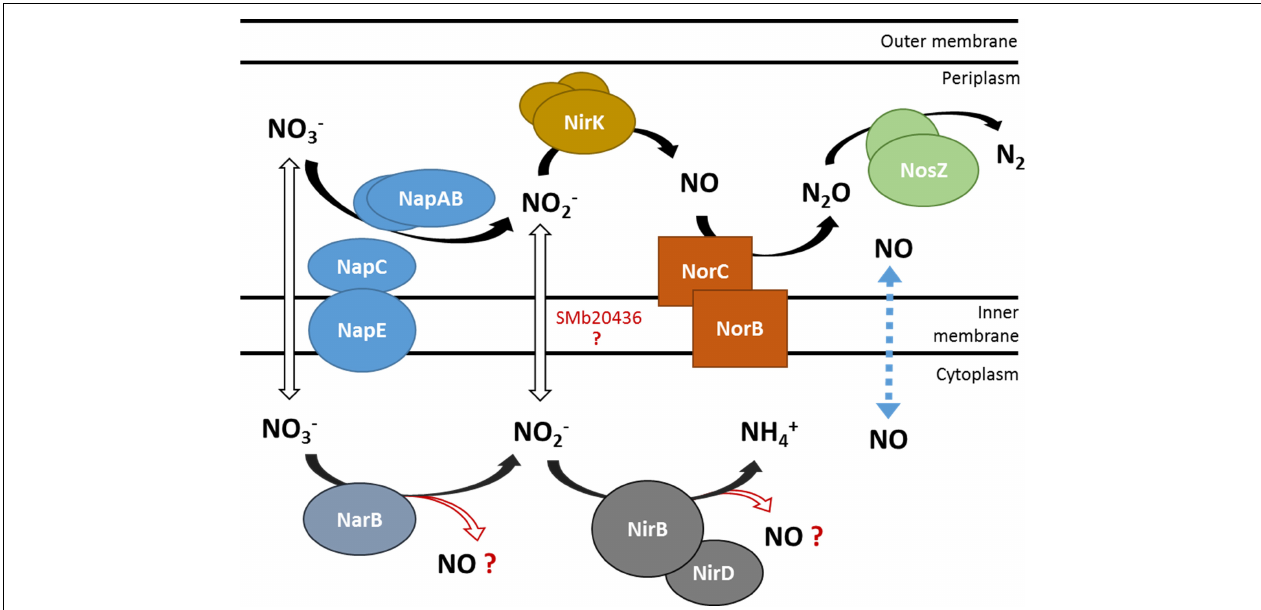
FIGURE 1 | Schematic representation of nitrate utilization and NO production by the denitrification and putative NarB NirB pathways. NO 3 - and NO 2 - transporters are not identified yet in S. meliloti . The dotted line represents NO diffusion across the cytoplasmic membrane. Enzymes involved in the denitrification pathway: Nap (nitrate reductase), Nir (nitrite reductase), Nor (NO reductase), Nos (nitrous oxide reductase). SMb20436: B. japonicum NarK homolog, putative nitrite transporter. NarB, putative assimilatory nitrate reductase; NirBD, putative assimilatory nitrite reductase.